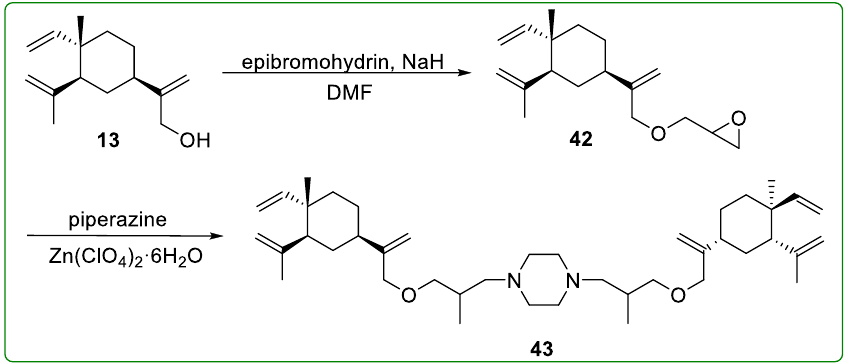
Figure 13. Chemical structures of β -elemene ether derivative 43 .